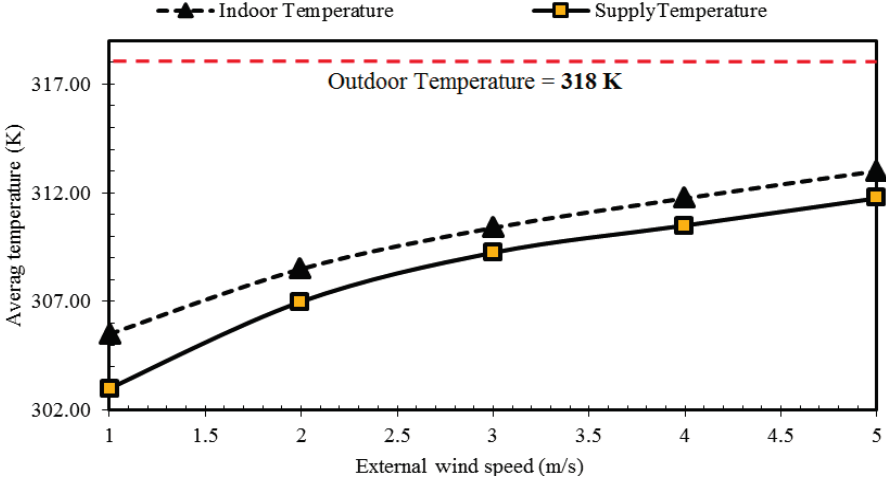
Figure 17. Effect of the wind speed on the indoor and supply air